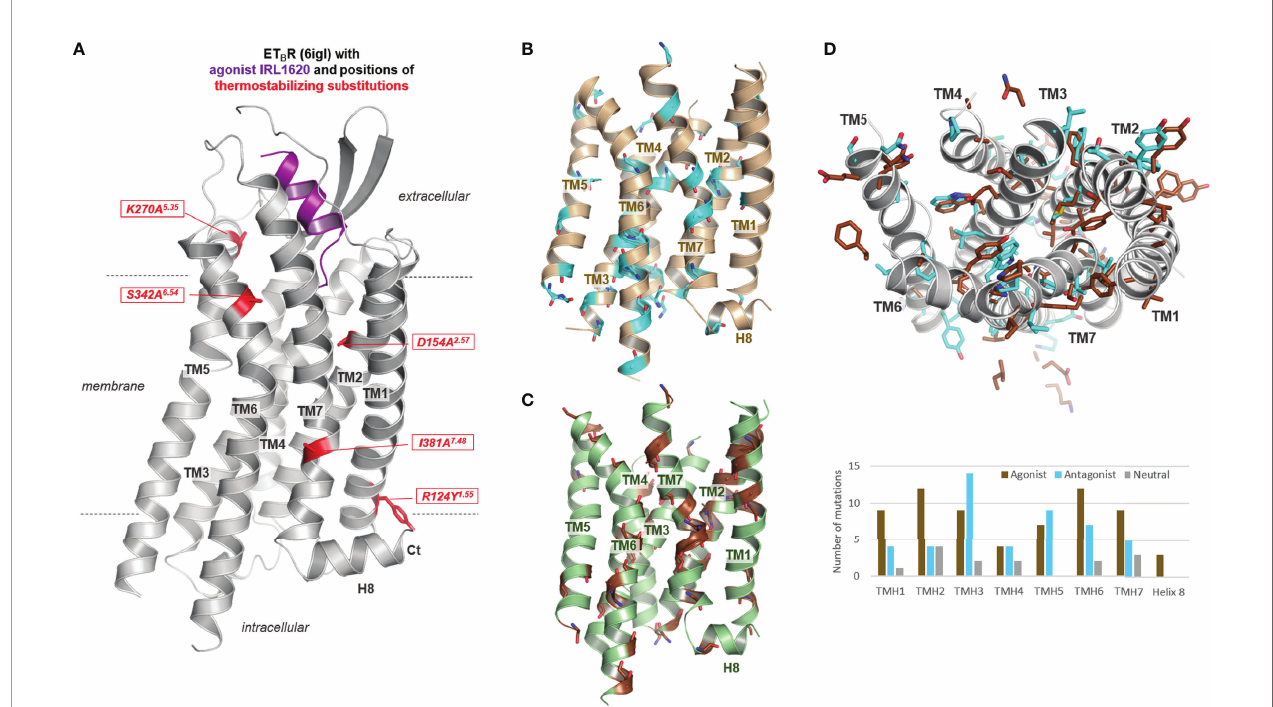
FIGURE 3 | Thermostabilizing mutations of the ET B R and thermostabilizing mutant positions reported for class A GPCRs. (A) The fi ve commonly and in combination used thermostabilizing ET B R substitutions are visualized at an active state structure bound with the agonist. These substitutions are also used for stabilizing inactive state and apo- state structures. (B) Positions (backbone as cyan-colored sticks) of thermostabilizing substitutions used for protein preparation of diverse class A GPCRs ( Supplementary Table S1 ) are highlighted in a rhodopsin model (only transmembrane helices), as well as (C) of thermostabilizing substitutions in determined active state structures highlighted in an opsin model (brown backbone sticks). This mapping demonstrates that substitutions contributing to thermostability can be principally designed at each transmembrane helix [see also diagram in (D) ]. (D) This depiction (top view from the extracellular side) of the rhodopsin/opsin wild-type side chains of positions in class A GPCRs used for thermostabilization of both states (~130 substitutions at 97 positions, Supplementary Table S1 ) demonstrates that they act in a contrasting manner, either by modulating the protein-membrane interaction or by changes of intramolecular interactions participating in the regulation of activity state-related conformations. The substitutions used for stabilizing class A GPCR structures either in the apo-, inactive-, or active-state (in the diagram termed as Agonist, Antagonist or Neutral according to the state of ligand occupancy) are located at each helix, however, more identi fi ed mutants to stabilize active than inactive state conformations are located in TM1, TM2, TM6, and TM7, whereby in TM3 and also in TM5/TM6 a high number of inactive state stabilizing mutations were identi fi